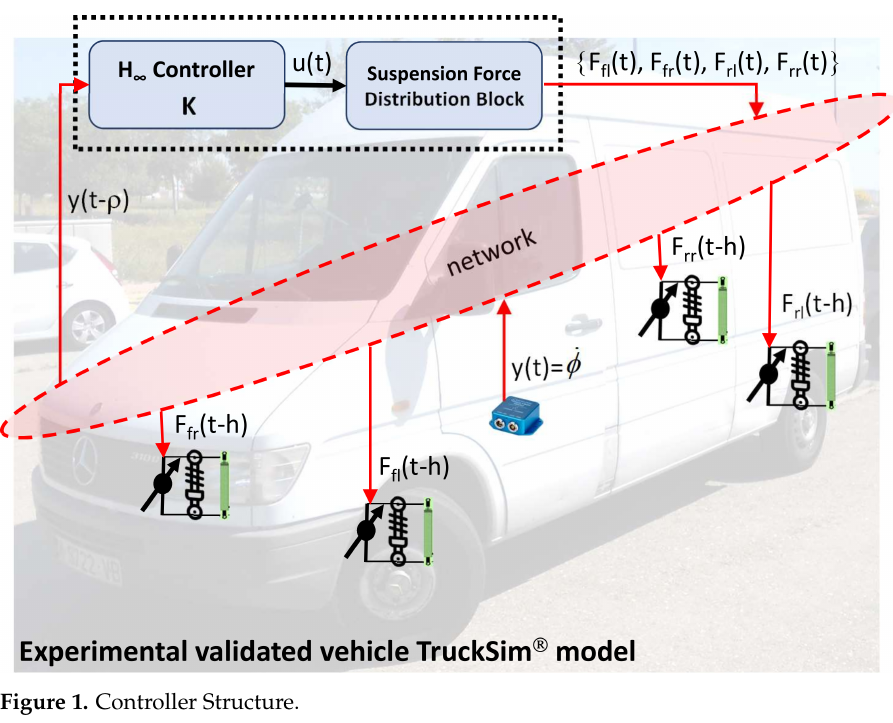
Figure 1. Controller Structure.